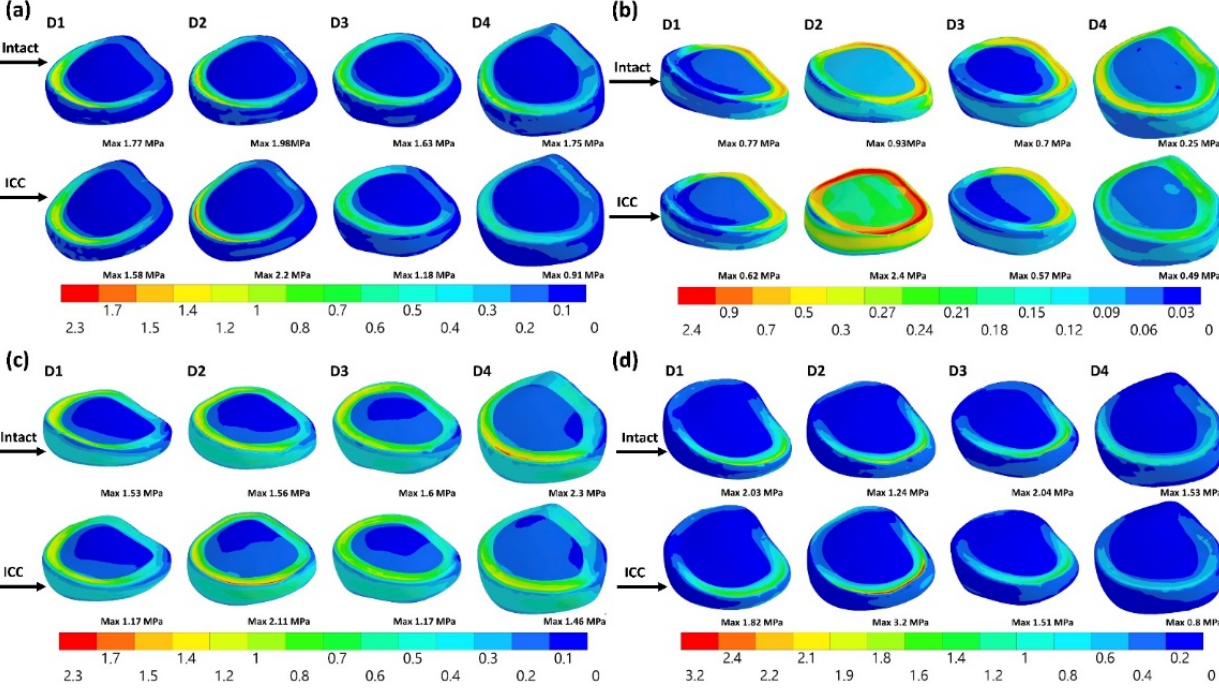
Figure 9. The equivalent stress of the disks in the ICC and intact lumber in flexion ( a ), extension ( b ), axial rotation ( c ), and lateral bending ( d ).